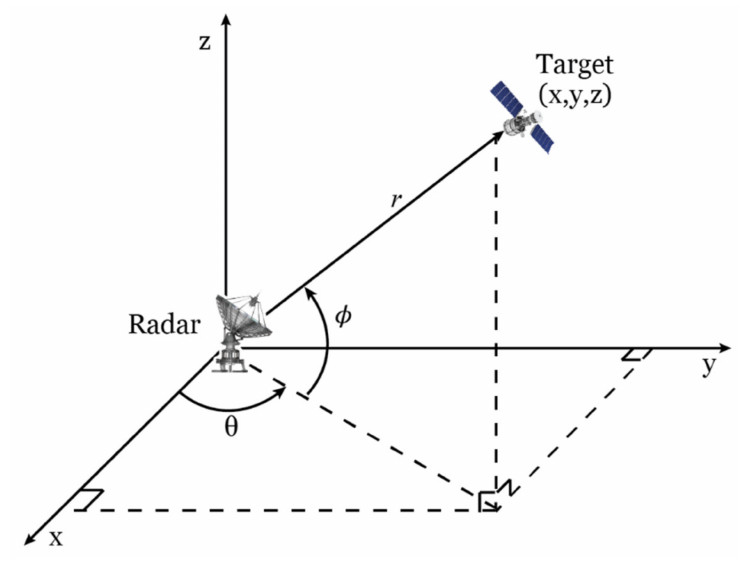
Figure 1. Radar tracking